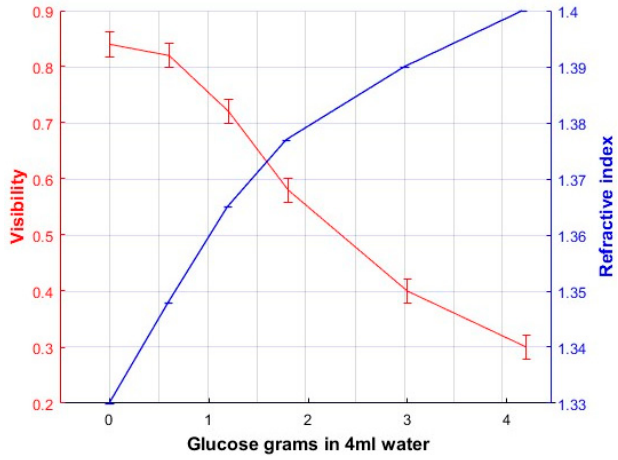
Figure 7. Calibration plot when solutions of glucose-water were considered.